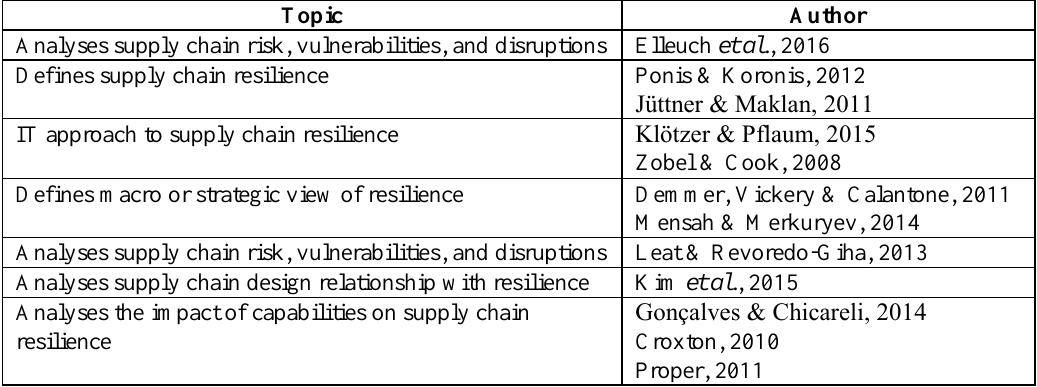
Table 1. Literature Review and Conceptualization of Supply Chain